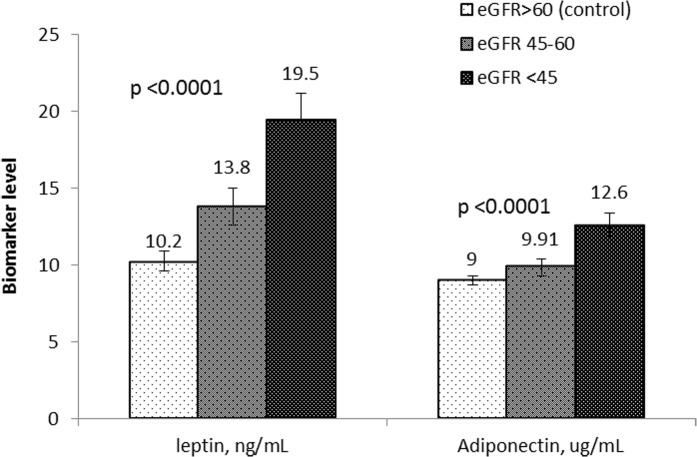
Adjusted* mean leptin and adiponectin levels by severity of CKD defined by eGFR levels.* Adjusted for age, sex, ethnicity, primary/below education, diabetes, CVD, BMI, systolic BP, current smoking, ever drinker, total and HDL cholesterol. p-value represents difference in adjusted mean levels of leptin and adiponectin by eGFR categories.